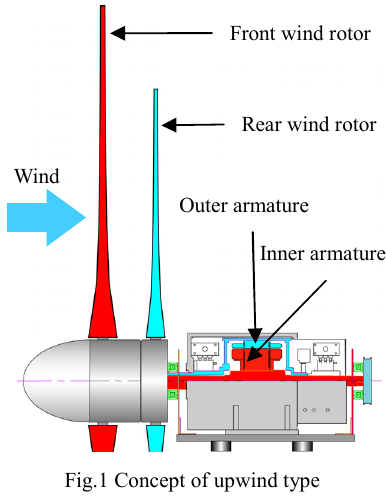
Fig.1 Concept of upwind